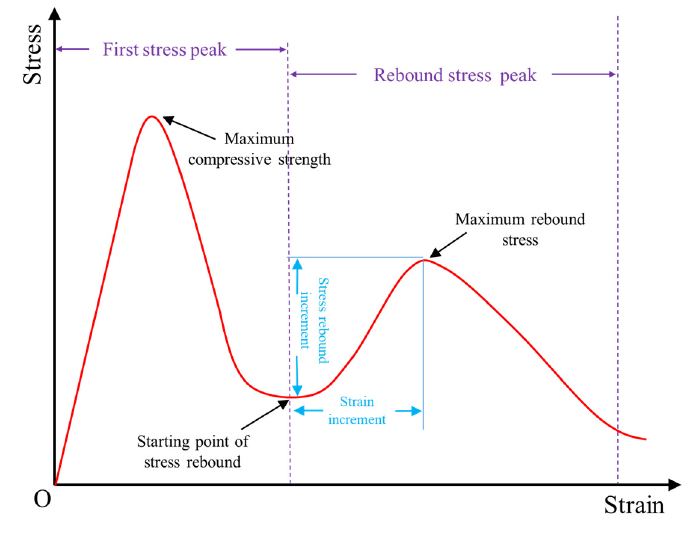
Figure 7. Stress–strain curve model.